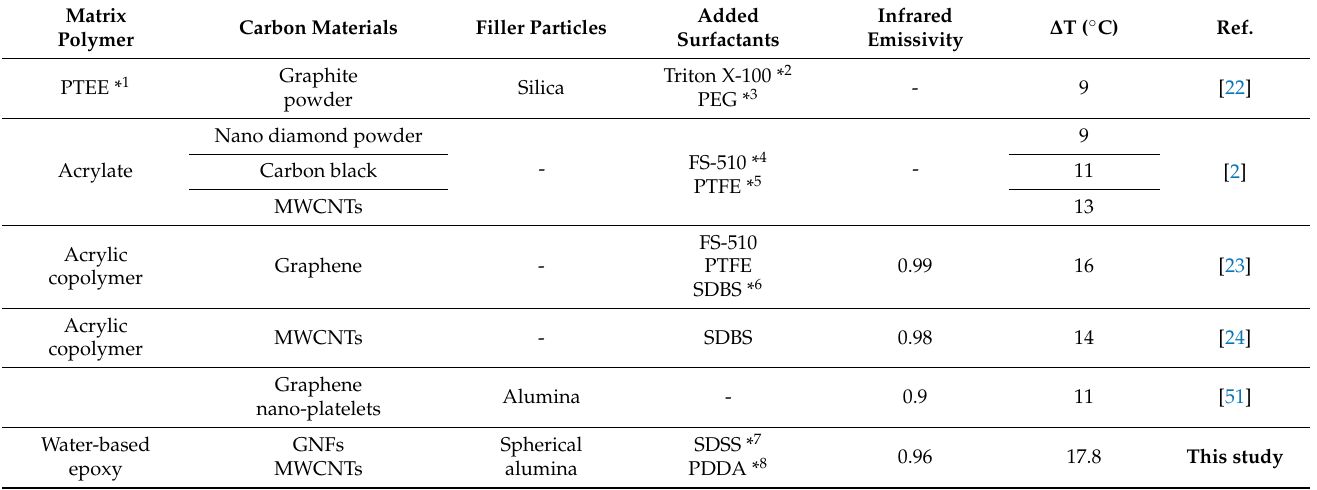
Table 2. Comparison of the cooling performance and materials of various heat dissipation coatings in the